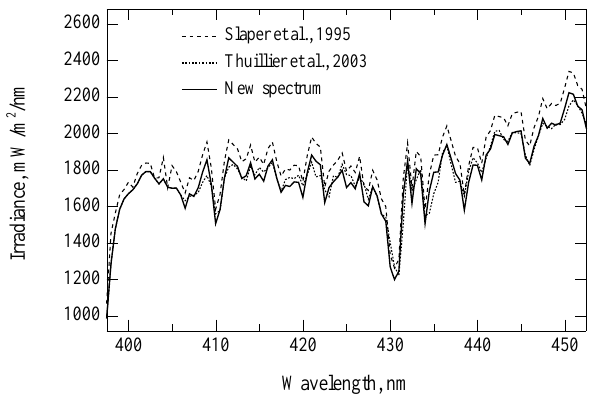
Fig. 2. Extraterrestrial spectra between 400 and 450nm: Slaper et al. (1995) in dash-line; Thuillier et al. (2003) in microdash-line and the “new spectrum” constructed from both in